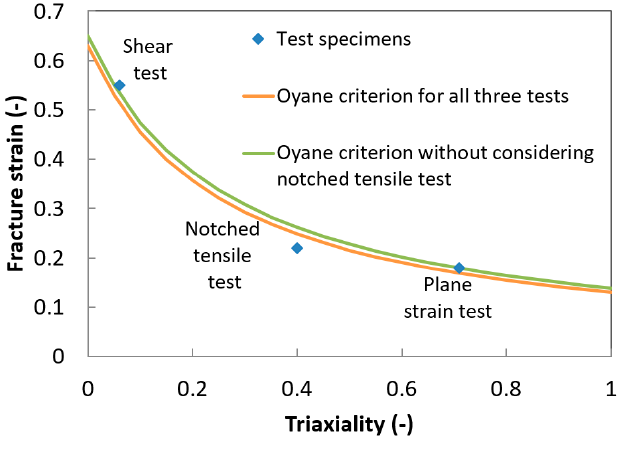
Figure 31. Graphic representation of the Oyane criterion.